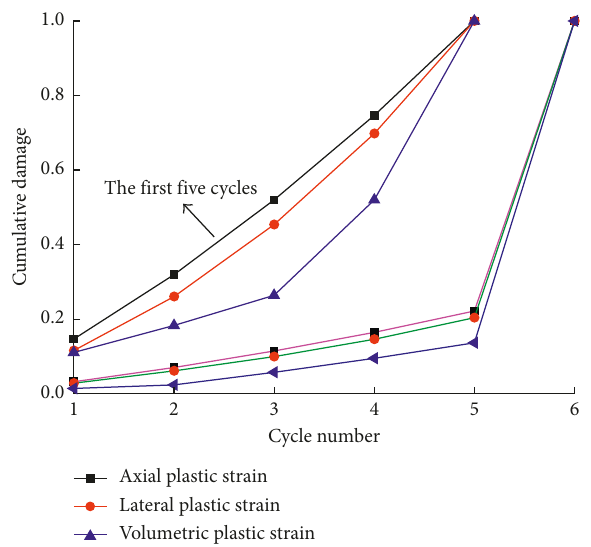
Figure 12: Comparison of cumulative damage based on plastic strain.